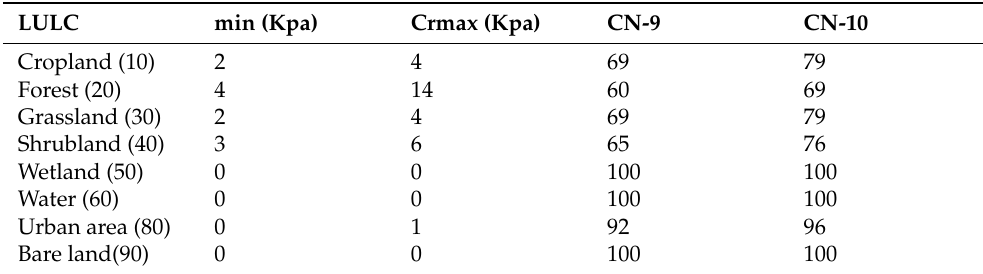
Table 1. The parameter values used for different LULC of the study